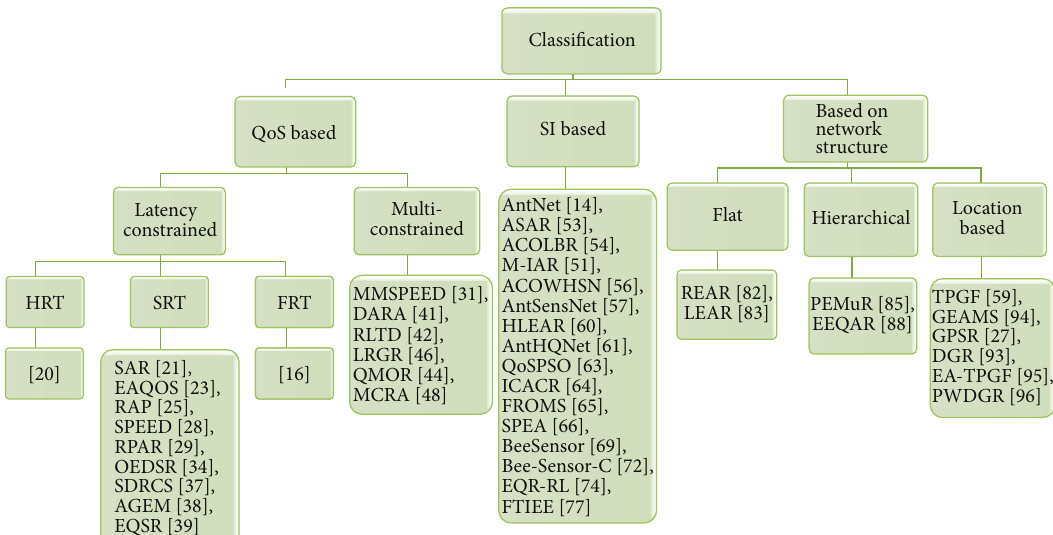
Figure 2: Classification of routing protocols in